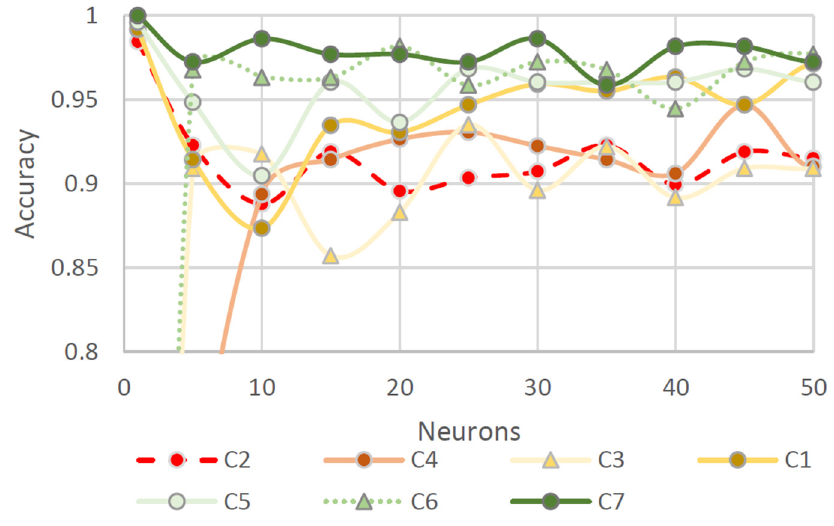
Figure 7. Illustrative example of the evaluation of neurons for the Canon device. The colours represent the mean accuracy of the ANN from green (the best learned chart) to red (the worst). Having selected the best model to predict the hue, the last stage in our study was to predict the remaining two variables, value and chroma. By following the same process as in the rest of the experiments, we obtained the results provided in Table